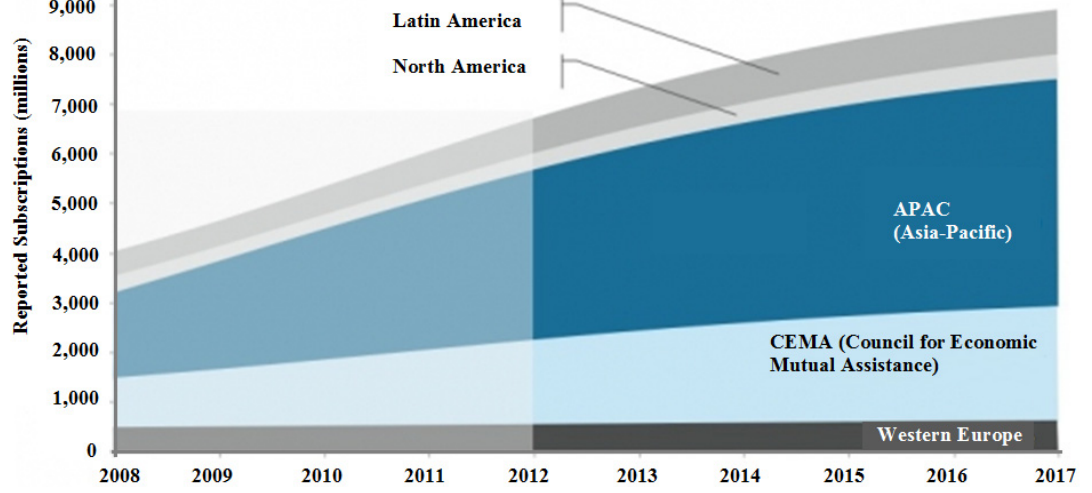
Figure 1. Mobile telecommunication network subscription (2008–2017)